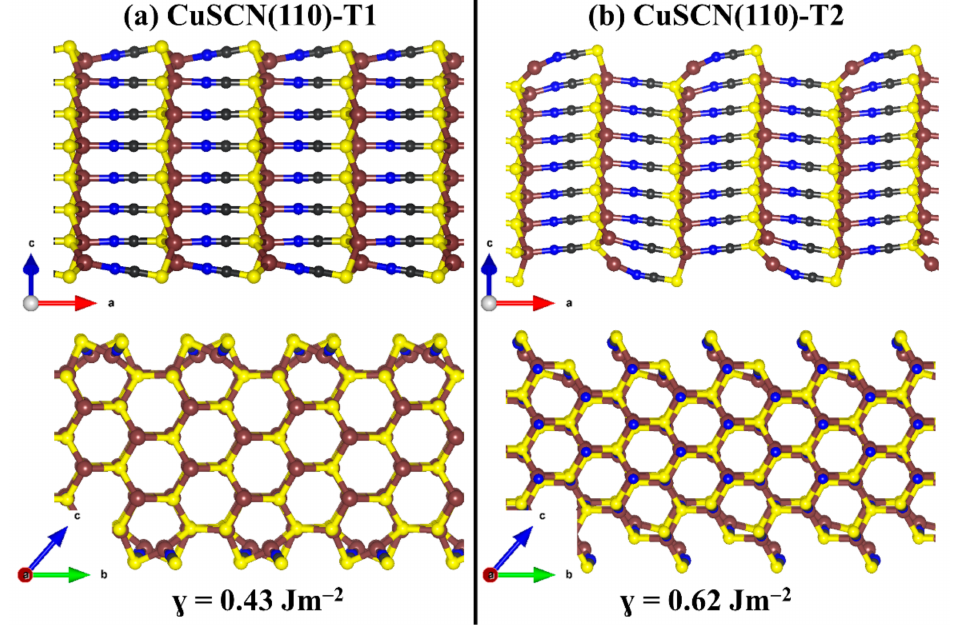
Figure 5. Side views of the optimised structures of the two non-dipolar ( a ) T1 and ( b ) T2 terminations of β -CuSCN (100) surface. Atomic colour: brown = Cu, grey = C, blue = N, and yellow =